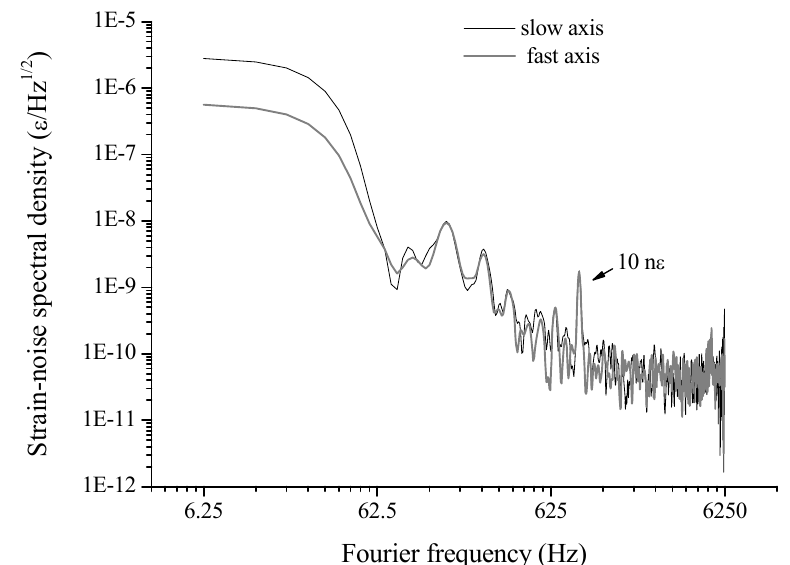
Figure 11. Response to dynamic strain of fast and slow axes cavity modes in laser-locked condition for a 10 n  signal applied to the intra-cavity